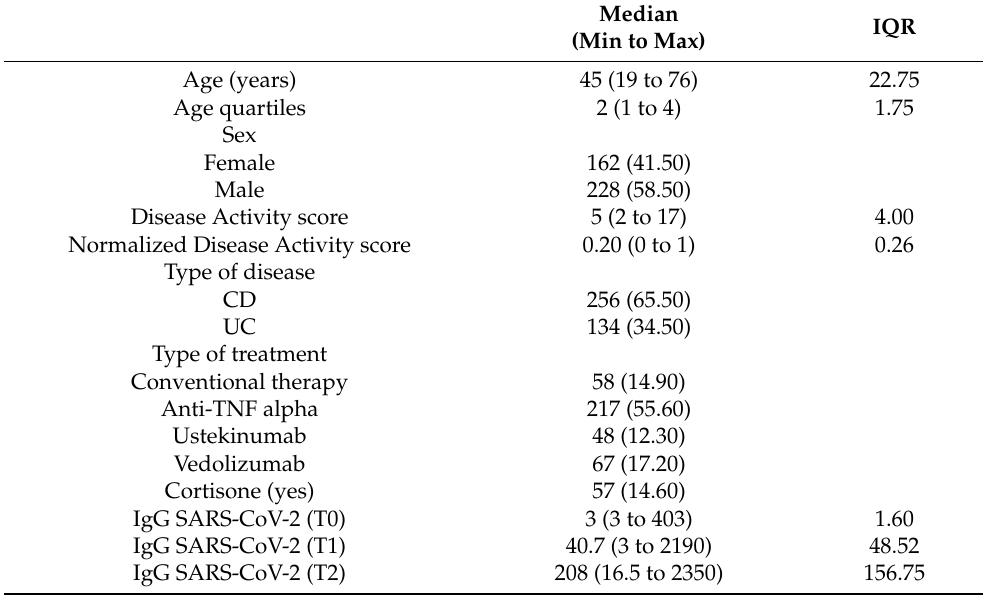
Table 1. Description of the whole sample. N: